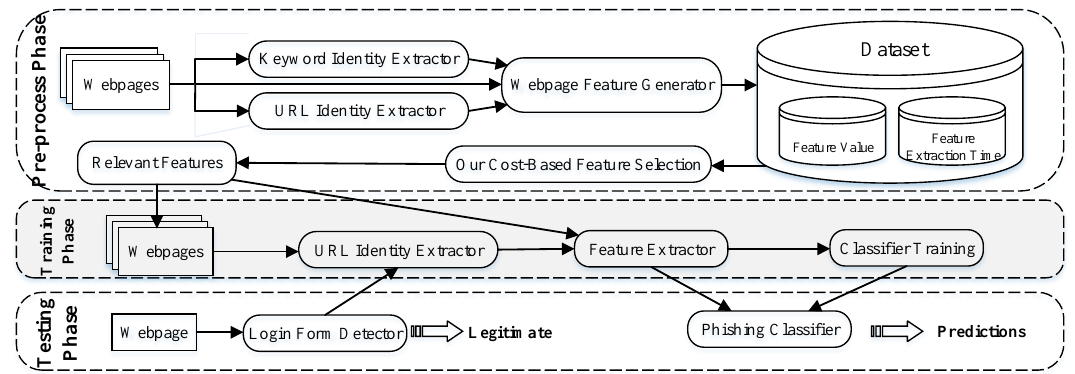
Figure 1. Proposed architecture